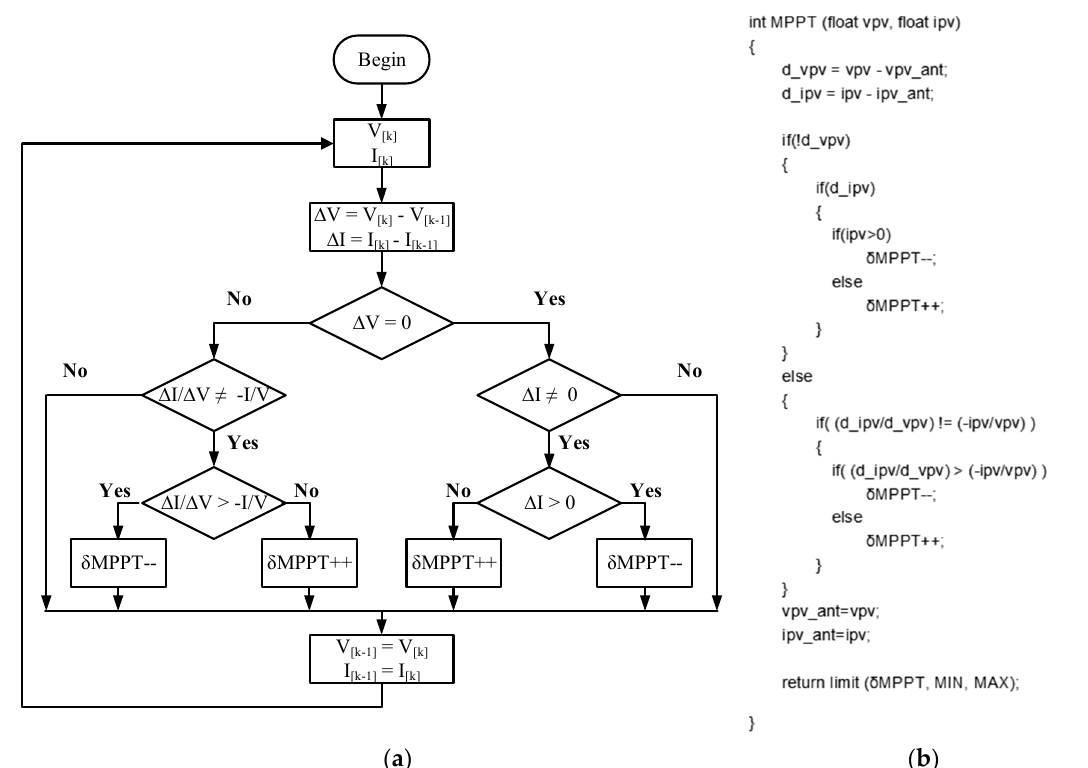
Figure 4. Incremental conductance maximum power point tracker (MPPT) control algorithm: ( a ) Flowchart of the control algorithm; ( b ) Example of the control algorithm implemented in C language.